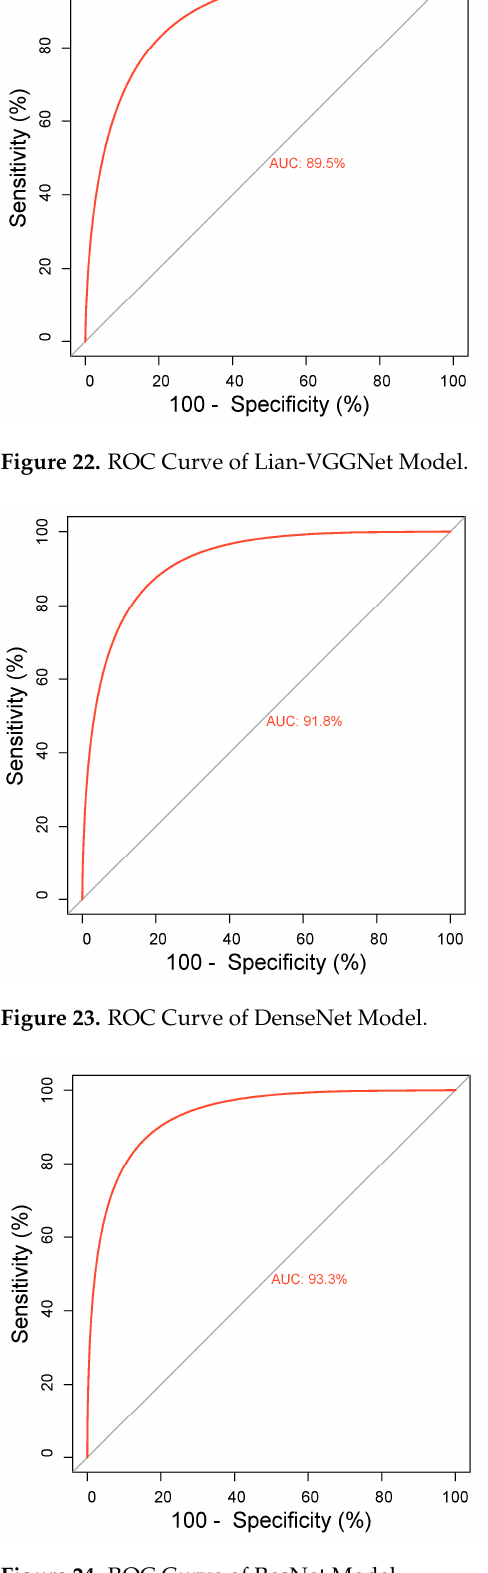
Figure 25. ROC Curve of SE-VGGNet Model .